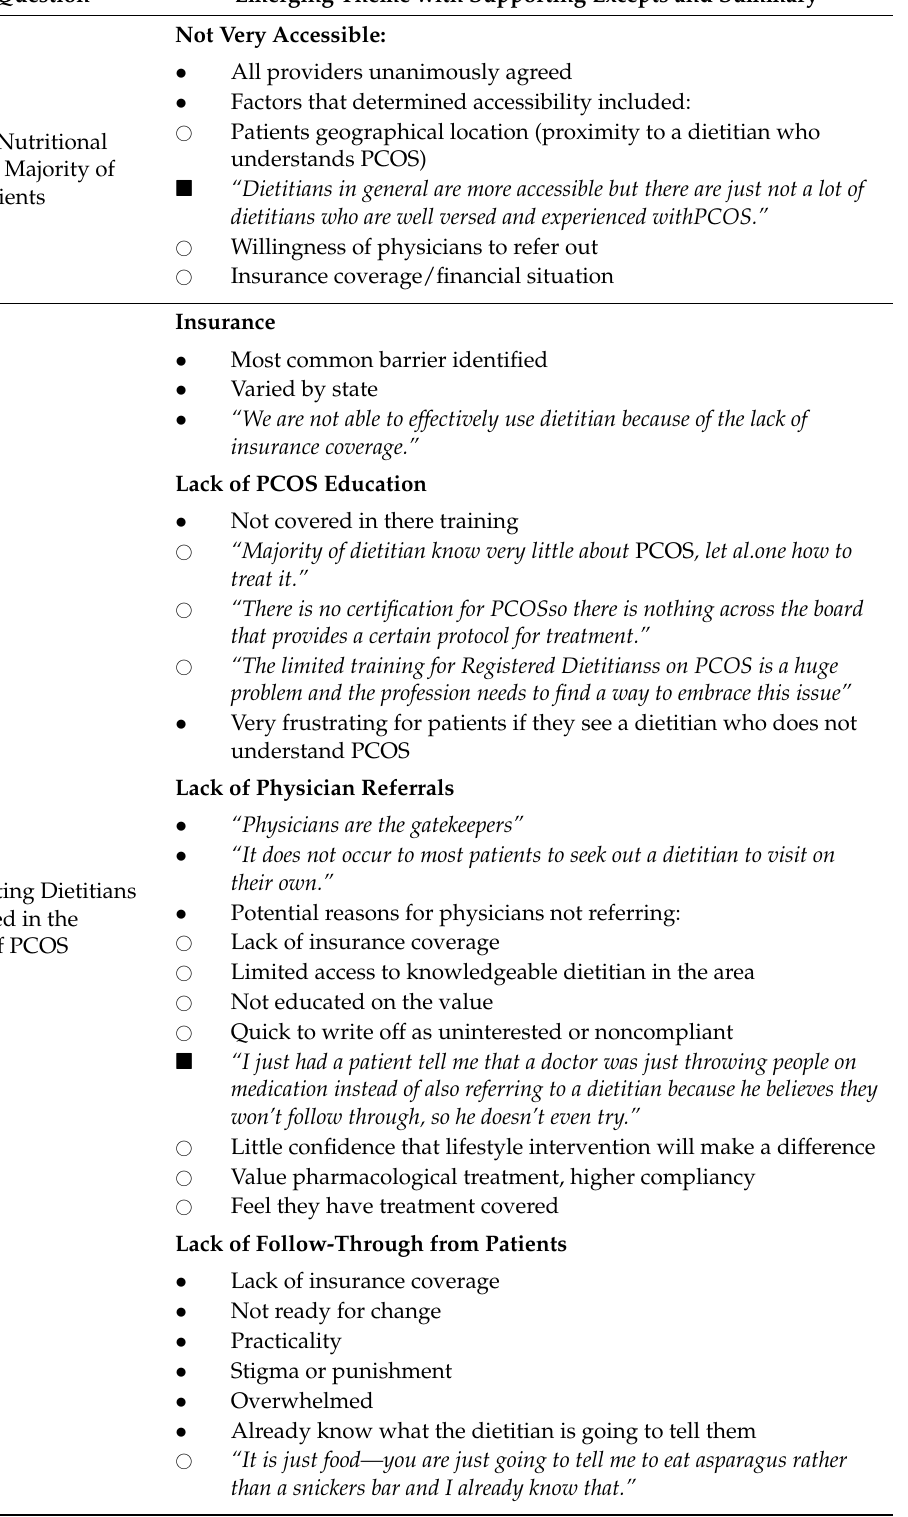
Emerging Theme with Supporting Excepts and